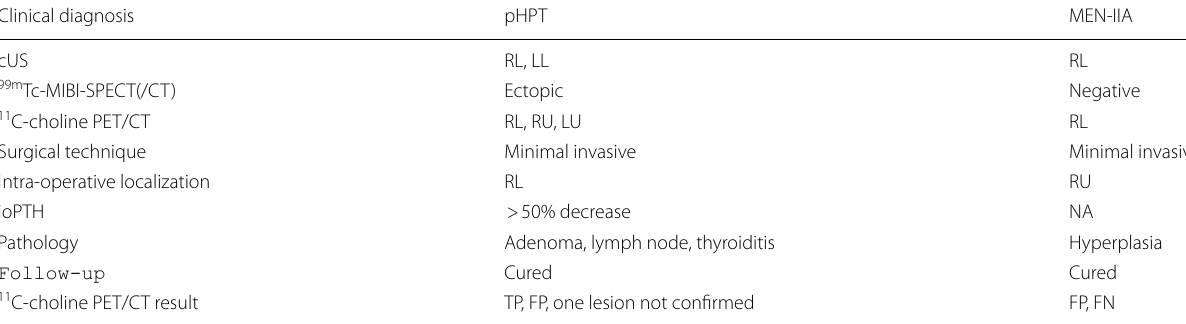
2) and false negative (n =